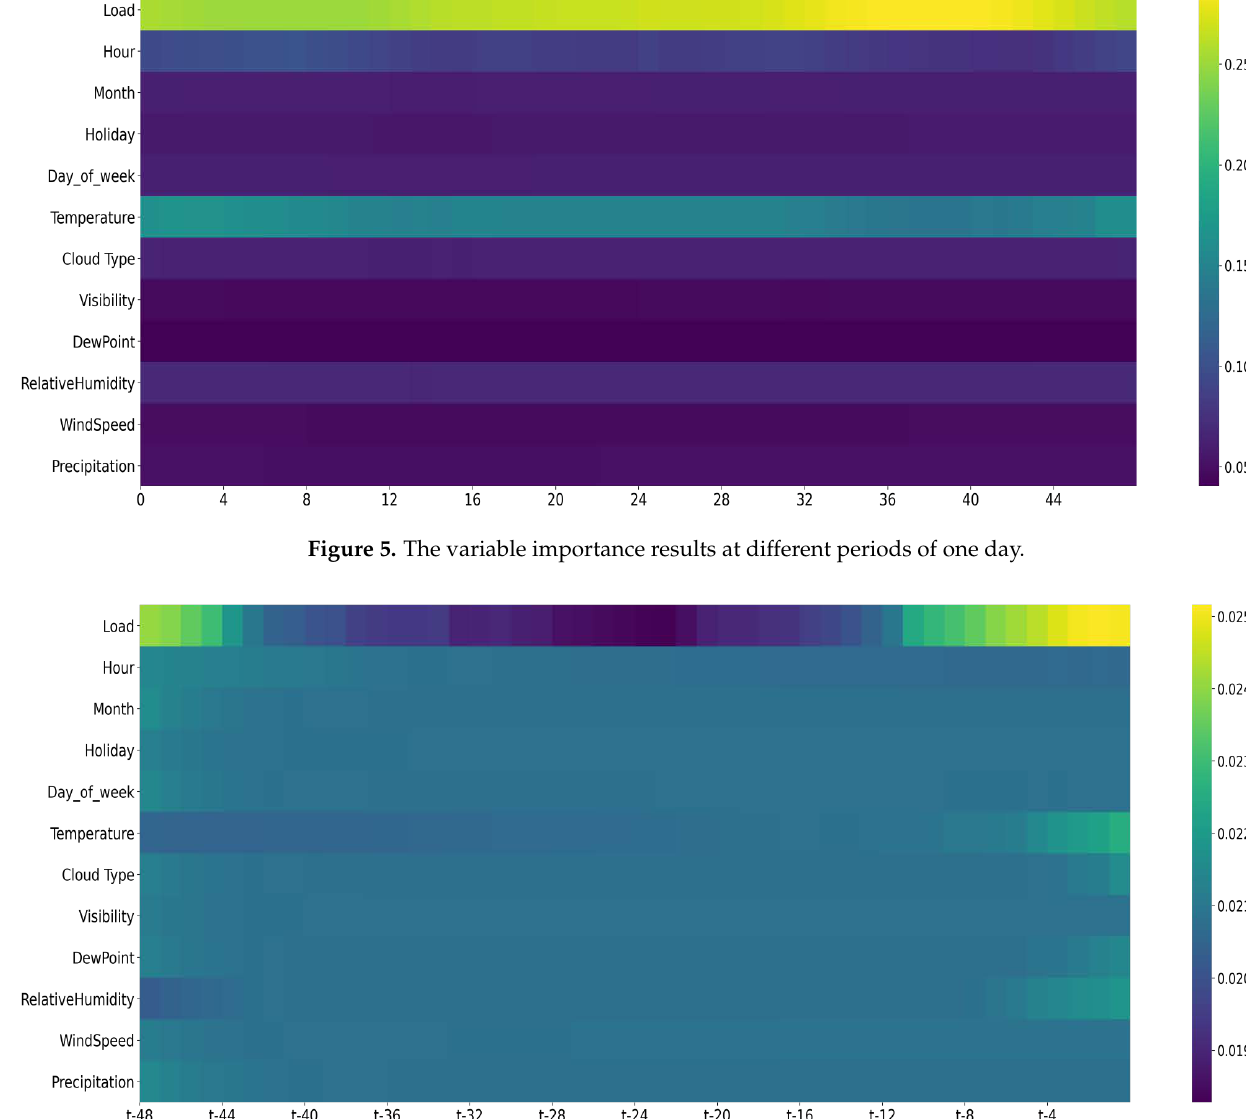
Figure 6. The variable-wise temporal importance of the proposed